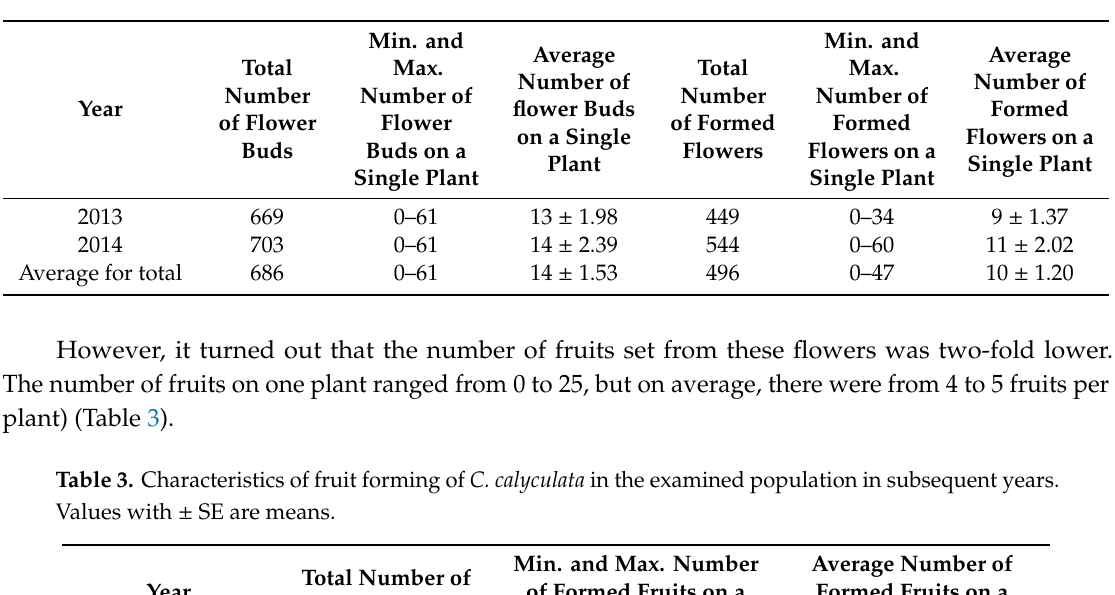
Table 2. Characteristics of flowering of C. calyculata in the examined population in subsequent years. Values with ± SE are means.